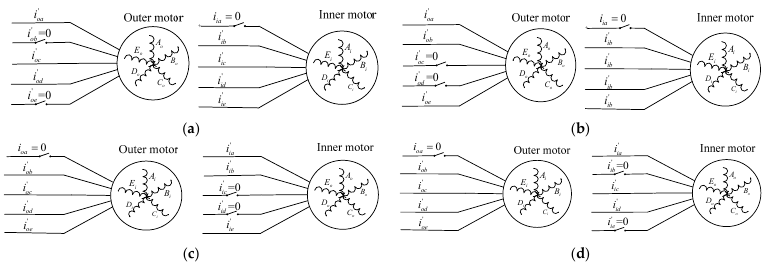
Figure 24. Double ‐ phase open ‐ circuit in one side of the motor with single ‐ phase open ‐ circuit in Figure 24. Double-phase open-circuit in one side of the motor with single-phase open-circuit in another side of the motor fault type (four types). another side of the motor fault type (four types). In fault type (I), phases “b” and “e” in the outer motor and phase “a” in inner motor being open ‐ circuit is a one fault case, while phases “c” and “a” in the outer motor and phase “a” in the inner